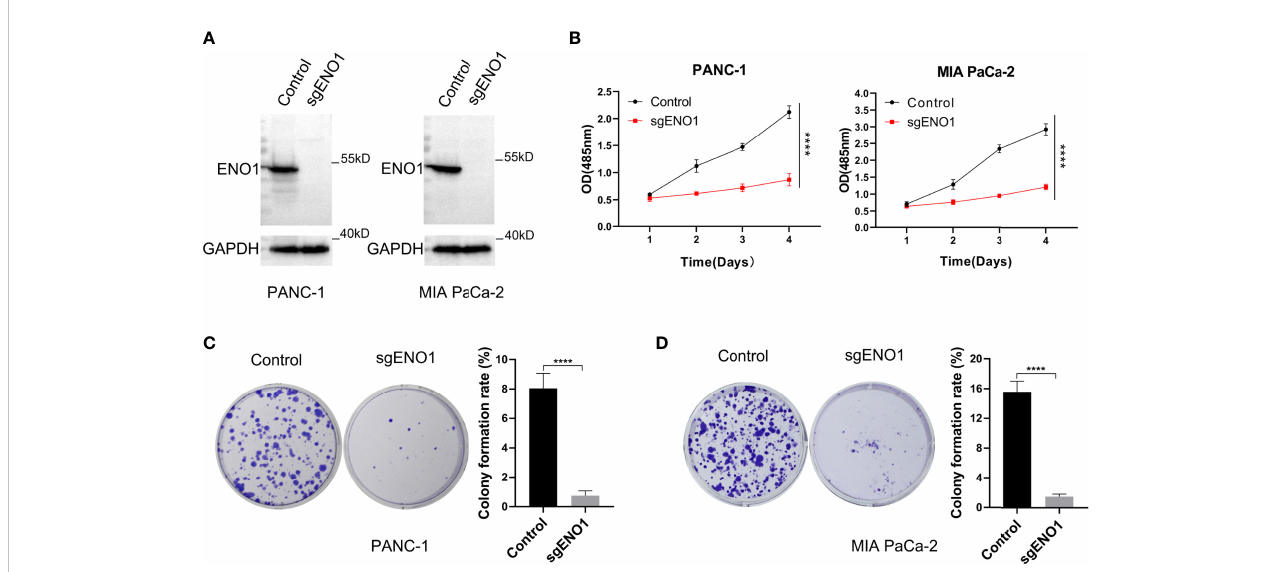
FIGURE 3 ENO1 knockout reduced the proliferation and colony formation ability of pancreatic cancer cells. (A) ENO1 knockout was validated by Western Blotting in PANC-1 and MIA PaCa-2 cells. (B) The cell proliferation (CCK-8 assay) and (C, D) colony formation rates were estimated in PANC-1 and MIA PaCa-2 cells after ENO1 knockout. 500 cells/well were seeded into the 6-well plates; ****P